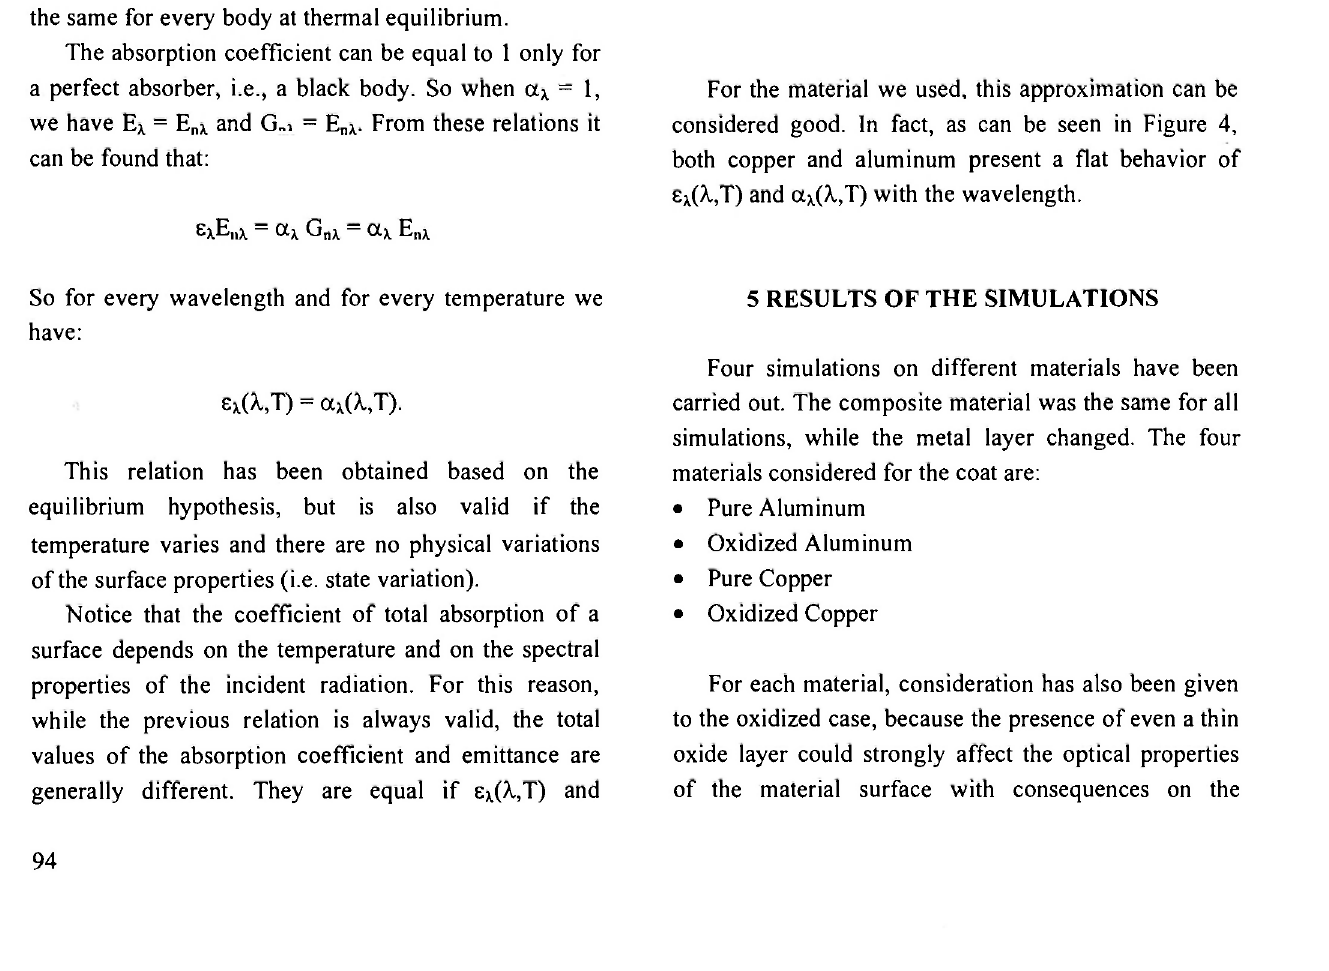
Fig. 3: Comparison between the emissive power of the black and grey body with a real